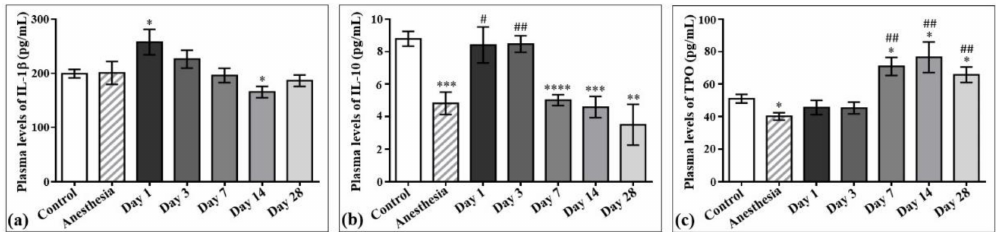
Figure 7. The effect of laser-driven UPEB exposure on IL-1 β , IL-10, and thrombopoietin (TPO) levels in the plasma samples of control rats and those exposed to irradiation. Plasma levels of IL-1 β ( a ), IL-10 ( b ) and TPO ( c ) in control and irradiated rats measured on the 1st, 3rd, 7th, 14th, and 28th day after irradiation. * p < 0.05; ** p < 0.01; *** p < 0.001; **** p < 0.0001; # p < 0.05; ## p < 0.01 (* compared to control; # compared to anesthesia).